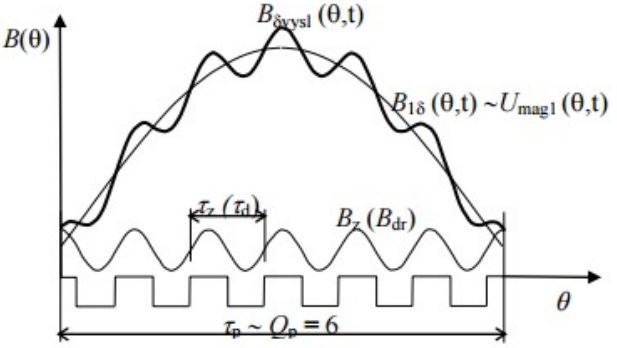
Figure 3. Course of magnetic induction in the air gap [2] .